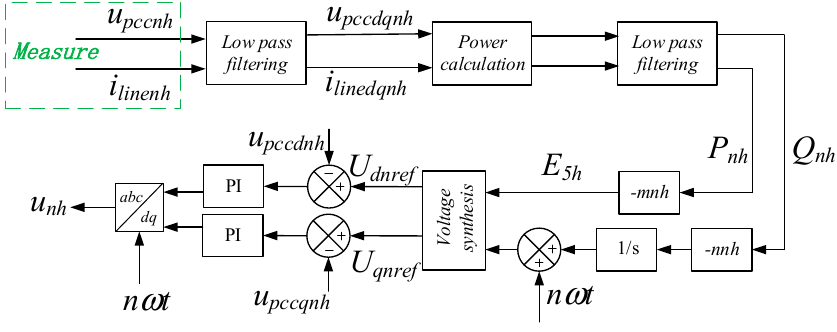
Figure 4. Harmonic drooping control structure.